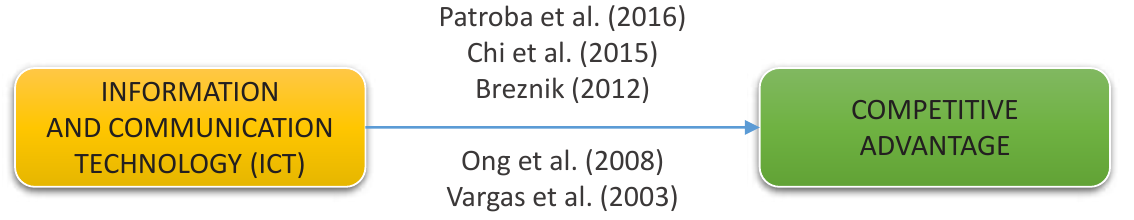
Figure 8. The information and communication technology relationship toward competitive